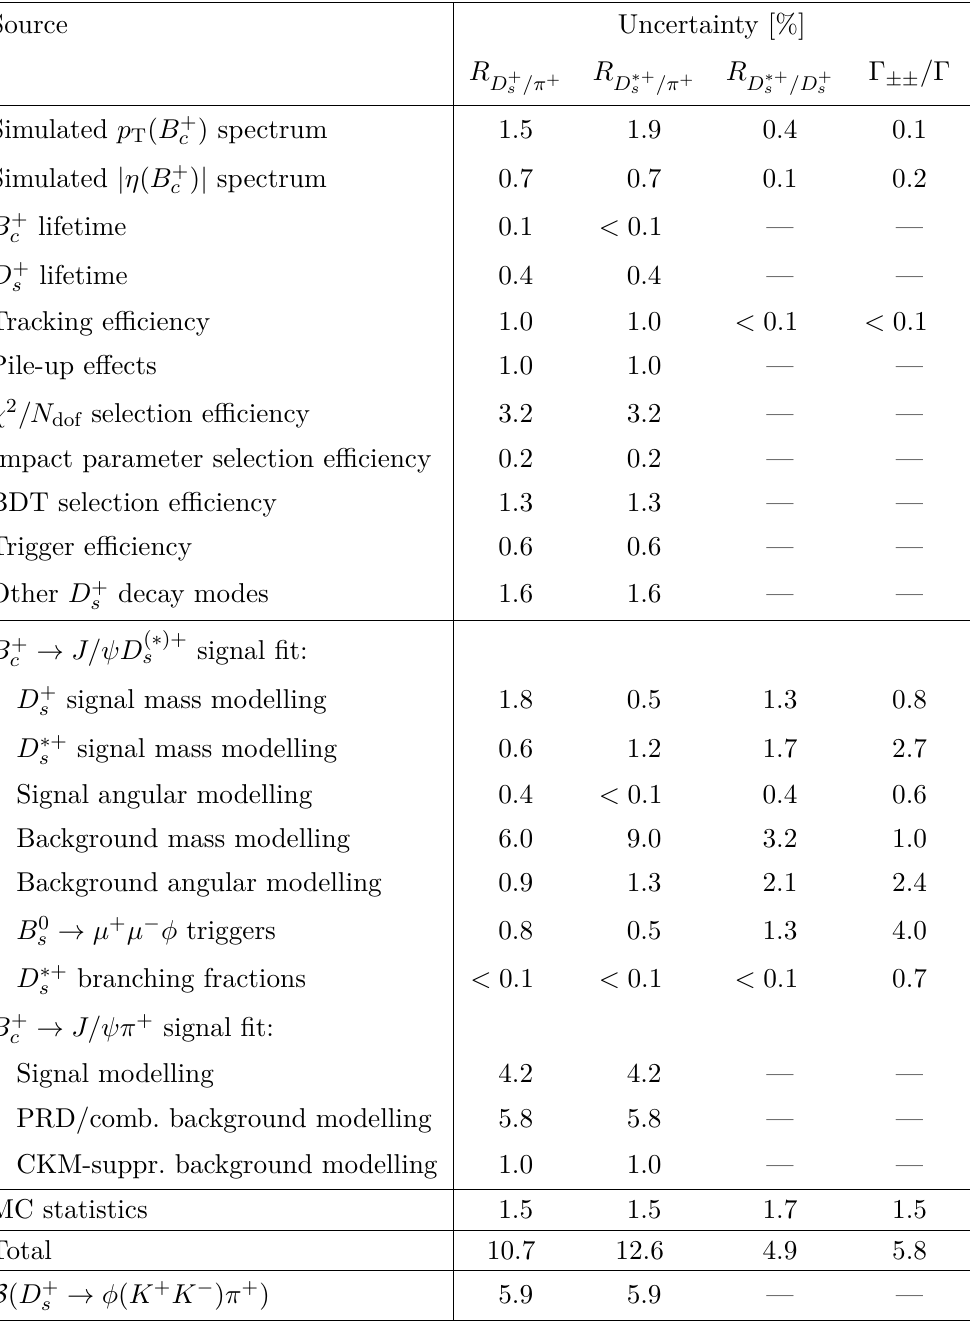
Table 4 . Relative systematic uncertainties of the measured